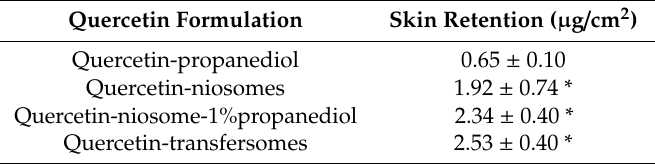
Table 6. Skin retention of free quercetin and quercetin-vesicles.